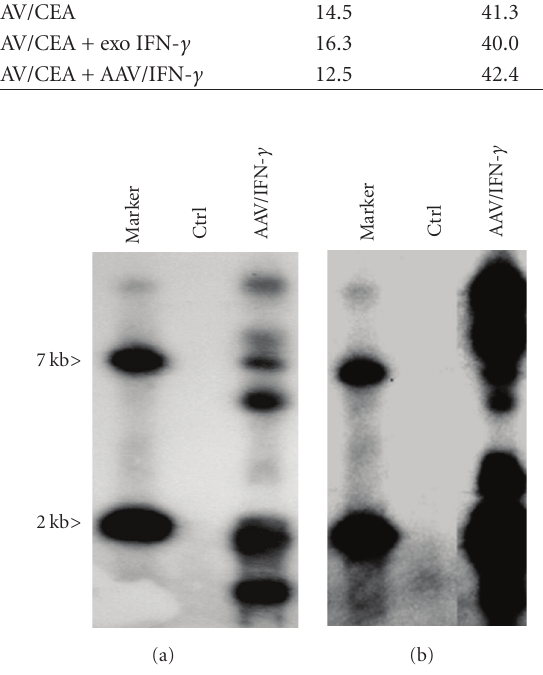
Figure 2: Chromosomal integration of AAV/IFN- γ vector DNA into DC and T cells. Cells were infected as described in the Materials and Methods section and then analyzed for proviral integration by, first, PCR amplification of the vector-chromosomal junctions, followed by agarose gel electrophoresis of the PCR products, Southern blotting and probing with 32 P labeled vector DNA. Each band represents a separate AAV integrant within the cell